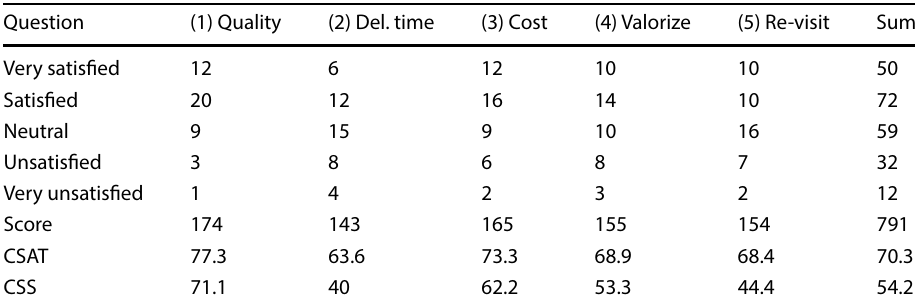
Table 19 The customer satisfaction measurement for group 2 (with need assessment)